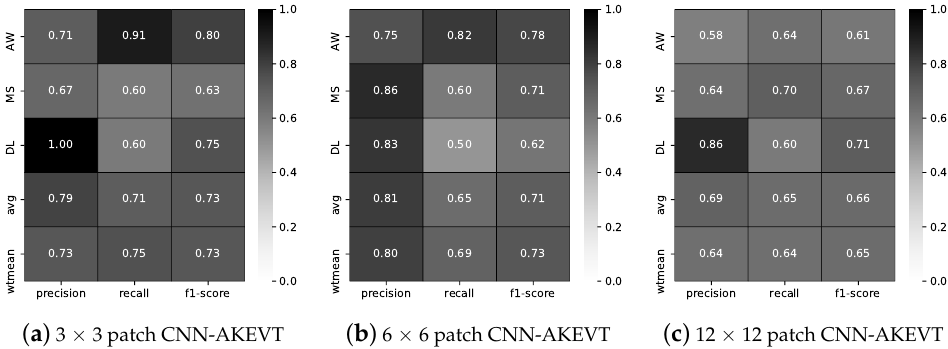
( b ) 6 × 6 patch CNN-AKEVT Figure 11. Validation statistics using field based vegetation observations for the CNN models trained using AKEVT dataset. (AW: Alder-Willow Shrub; DL: Dryas/Lichen Dwarf Shrub Tundra; MS: Mixed Sedge-Willow-Dryas Tundra, and W: Water. avg: average score; wtmean: area weighted mean score.)